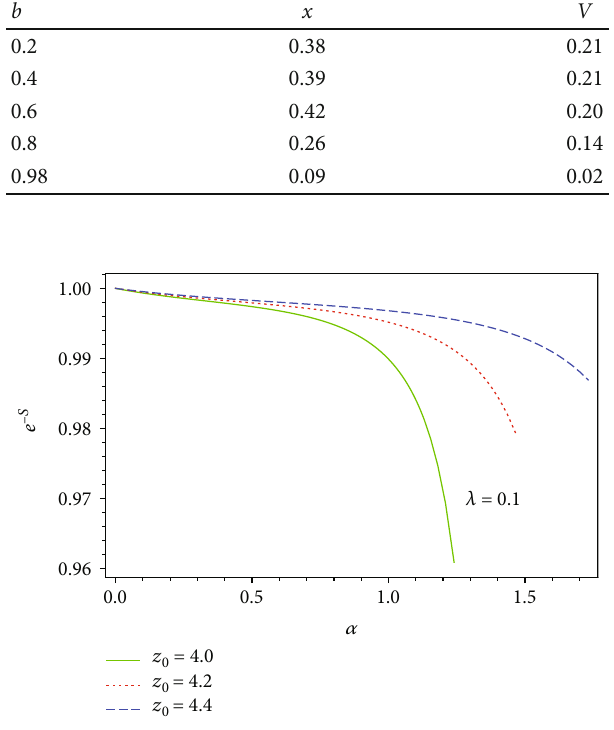
Figure 8: Considering pair production rate at zero temperature and fi xed value of scale parameter and di ff erent probe brane positions.